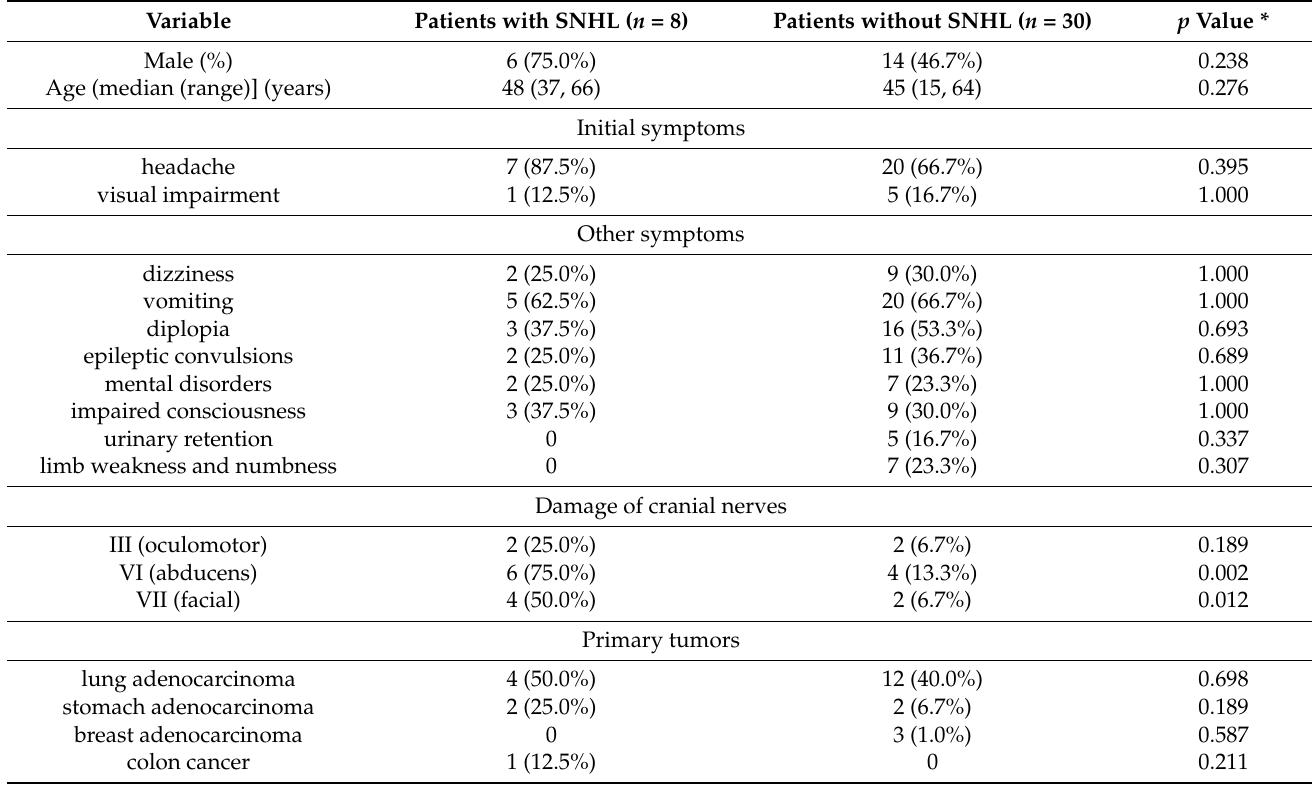
Table 1. The comparison of clinical characteristics of patients with SNHL and without